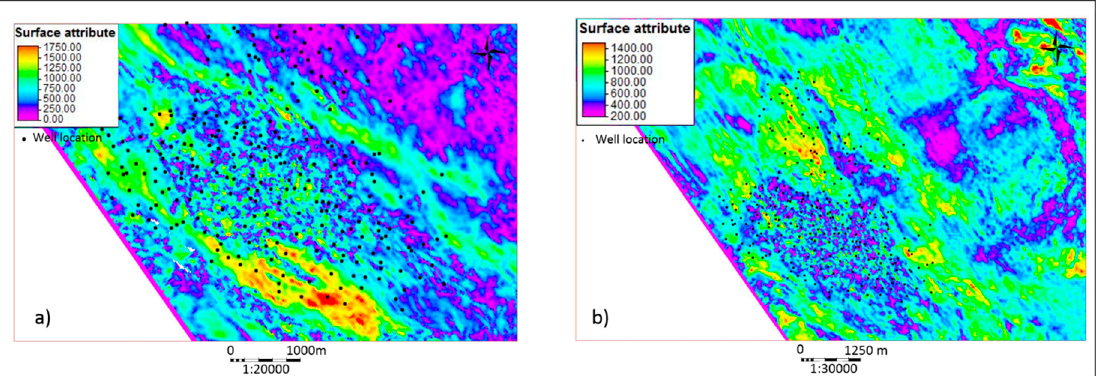
Figure 6. Sweetness attribute showing ( a ) an interval of 4 ms above and 4 ms below “UP” horizon and ( b ) an interval of 8 ms above and 8 ms below “LP” horizon [29].